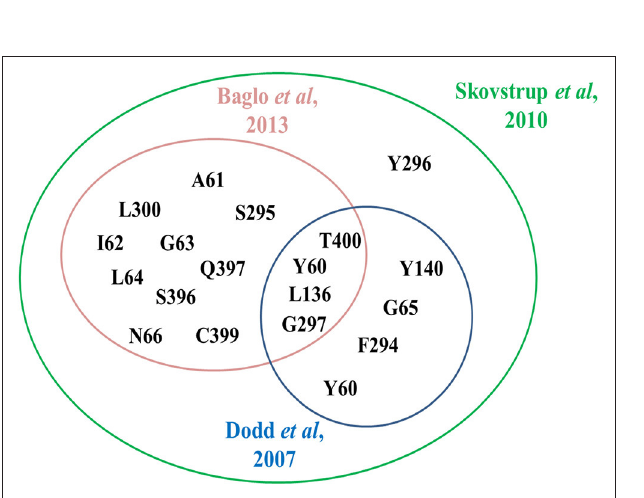
FIGURE 6 | Comparison of specific and overlapping interacting amino acid residues at GABA binding site in GAT1 determined by Skovstrup et al. with the residues identified by Baglo et al. and Dodd et al. FIGURE 7 | Comparison of binding mode of docked GABA, nipecotic acid